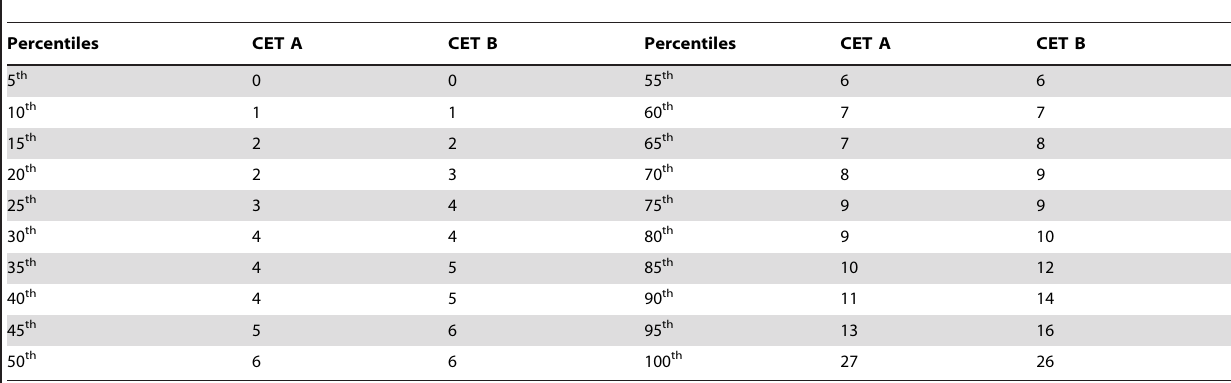
Table 6. Percentiles of the distribution of the adjusted error scores on the parallel versions of the CET.